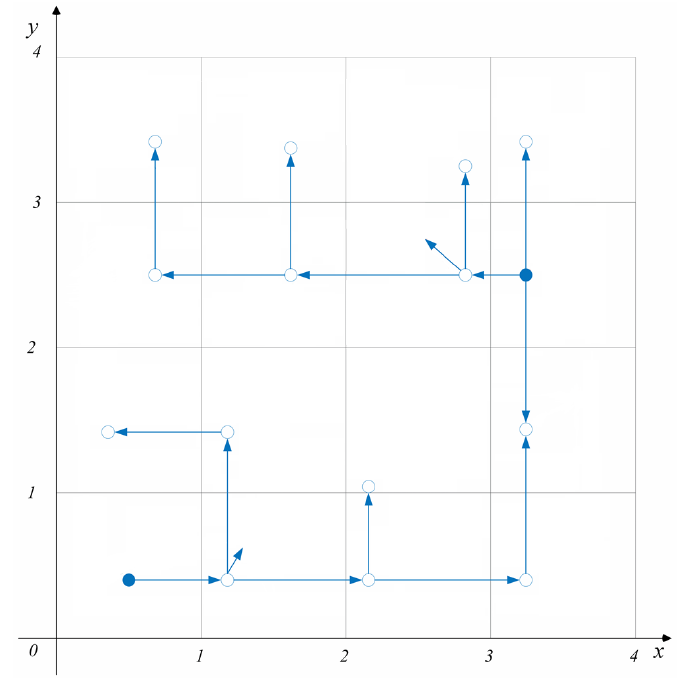
Figure 6. Example water supply